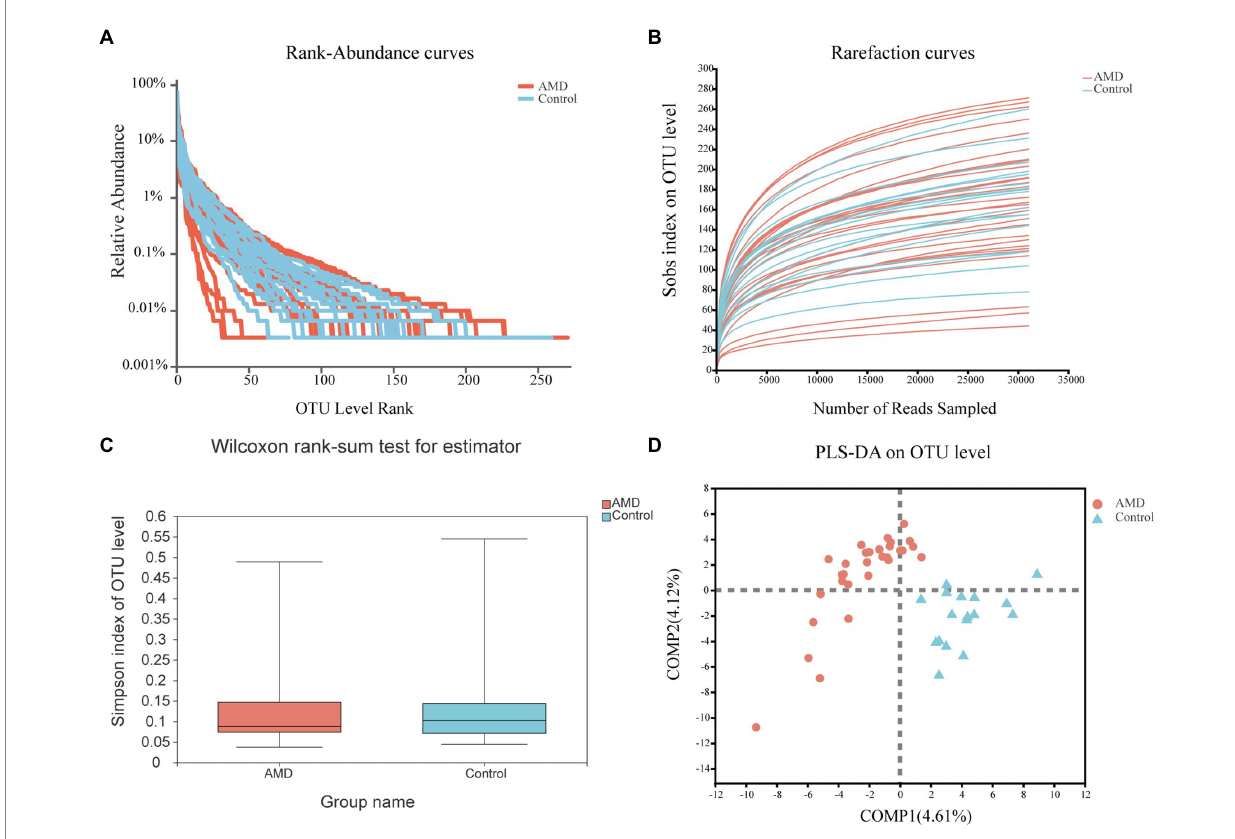
FIGURE 1 General sequencing characteristics of the 47 fecal samples and comparison of diversity in the age-related macular degeneration (AMD) patients and controls at the OUT level. (A) Rank-abundance curves of the gut microbiota. (B) Rarefaction curves (Sobs index) of the gut microbiota. (C) Comparison of alpha diversity in the AMD patients and controls. The Simpson index reflected the alpha diversity. (D) PLS-DA of the